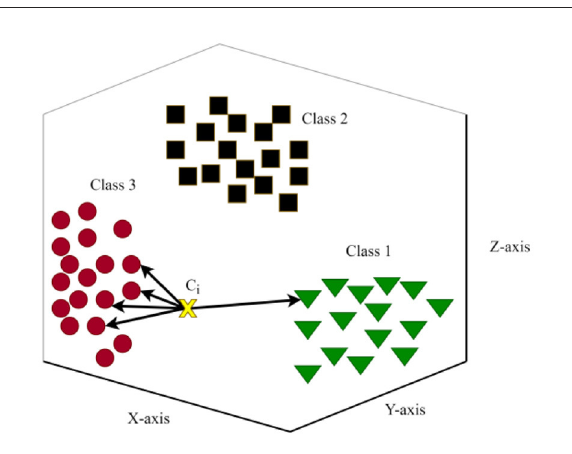
FIGURE6 A simple 3D multi-class KNN model for the rockburst